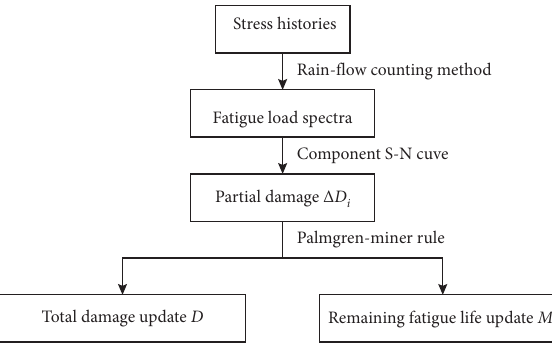
Figure 5: Adopted damage calculation